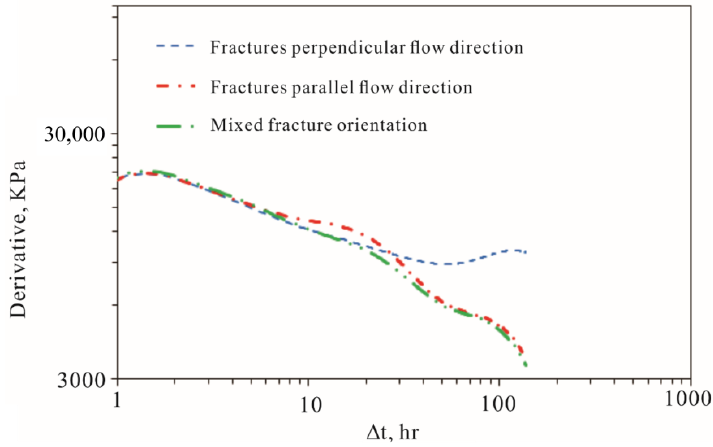
Figure 12. Comparison of the derivative plots between different fracture orientations.